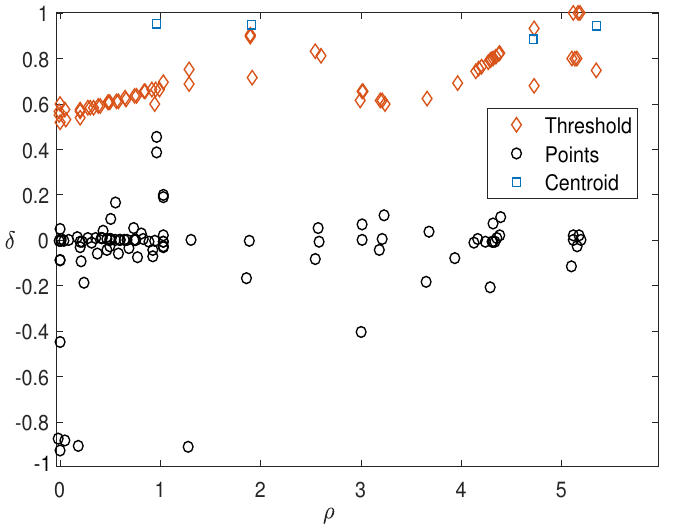
Figure 10. Decision graph for the time period t = 6 using the density peak algorithm and the probability density function.